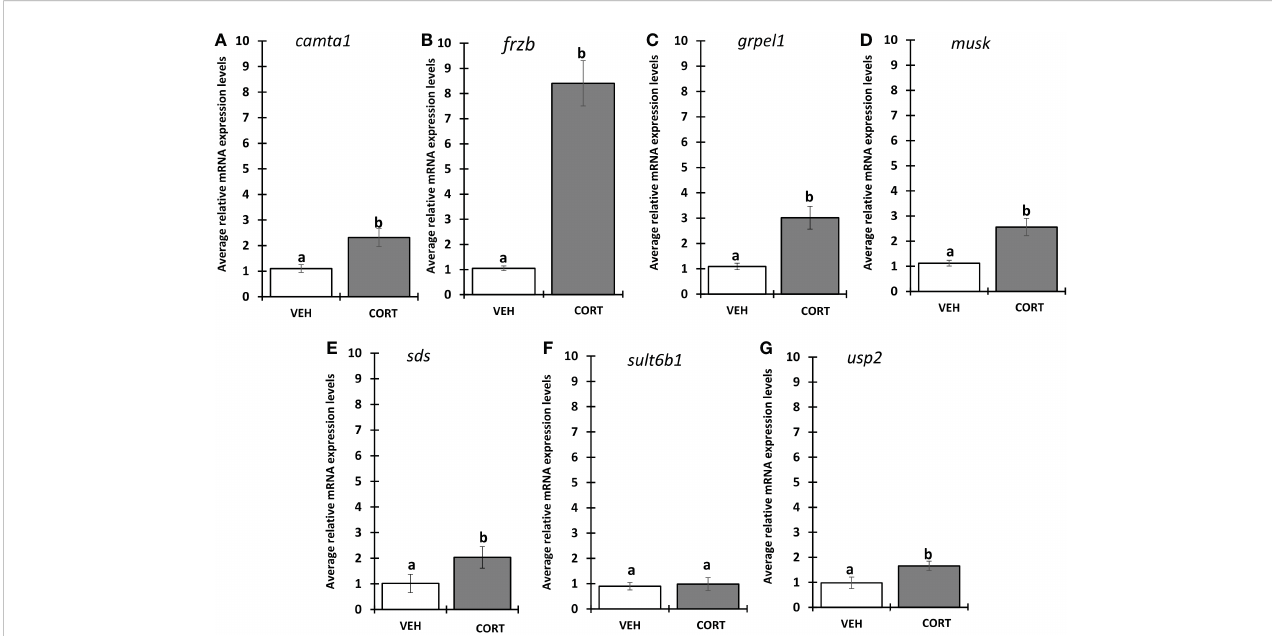
FIGURE 1 Evaluation of CORT response in selected genes. Premetamorphic tadpoles at Nieuwkoop and Faber stage 54 (NF54) were treated with vehicle control or 100 nM CORT (corticosterone) for 24 hours followed by tail RNA extraction and quantitative PCR to quantify mRNA expression using gene speci fi c primers for (A) calmodulin binding transcription activator 1 ( camta1 ), (B) frizzled related protein ( frzb ), (C) GrpE like 1, mitochondrial ( grpel1 ) (D) muscle associated receptor tyrosine kinase ( musk ), (E) serine dehydratase ( sds ), (F) sulfotransferase family 6B member 1 ( sult6b1 ), and (G) ubiquitin speci fi c peptidase 2 ( usp2 ). Bars represent mean mRNA levels relative to the housekeeping gene rpl8 and normalized to a vehicle control sample. n = 10 tail samples per treatment. Error bars represent SE. Letters indicate signi fi cant groups, p <